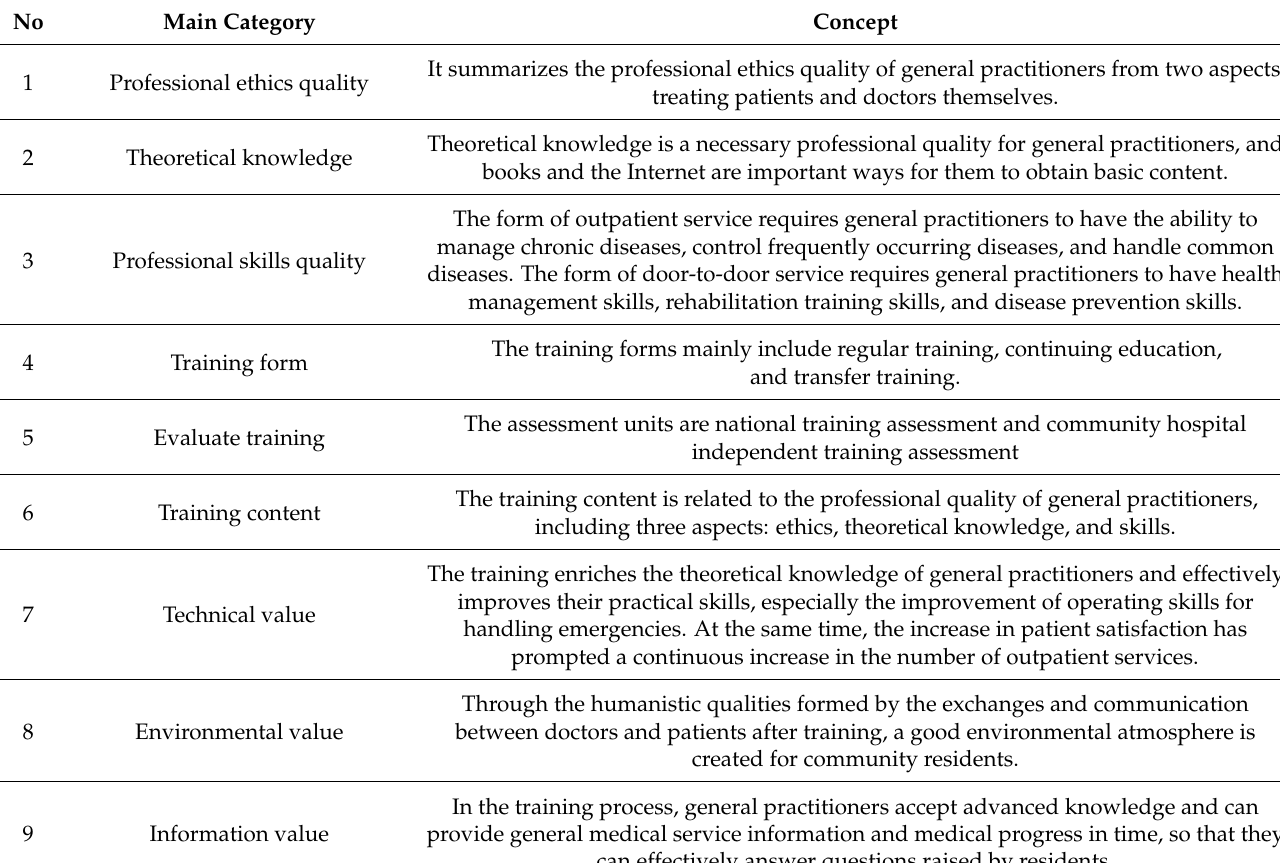
Table 2. Main concept categories and